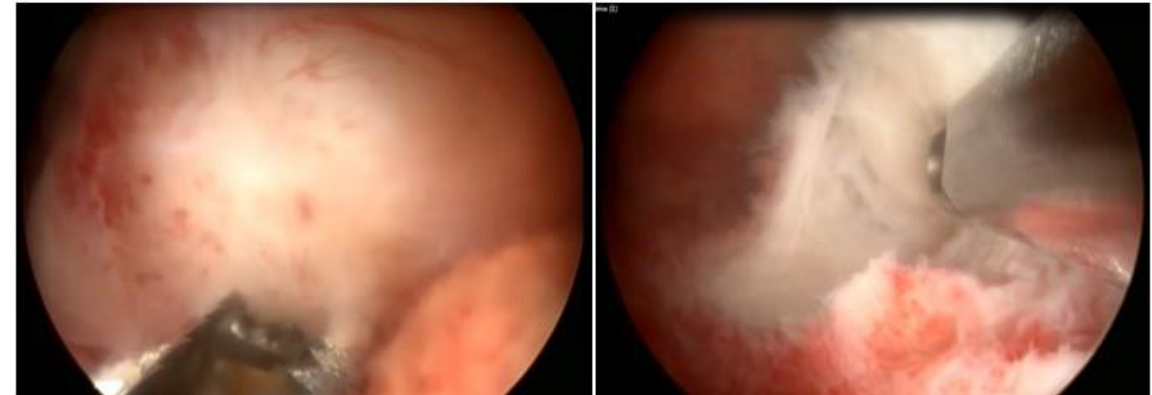
Figure 11. Morcellator technique — hysteroscopic mechanical tissue removal.